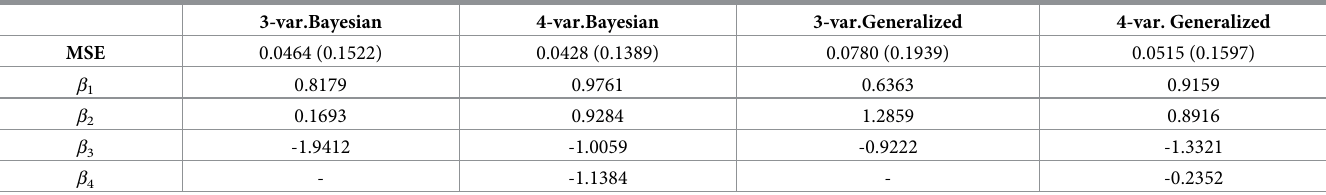
Table 5. Comparison between the Bayesian hierarchical log5 models and the generalized log5 models.